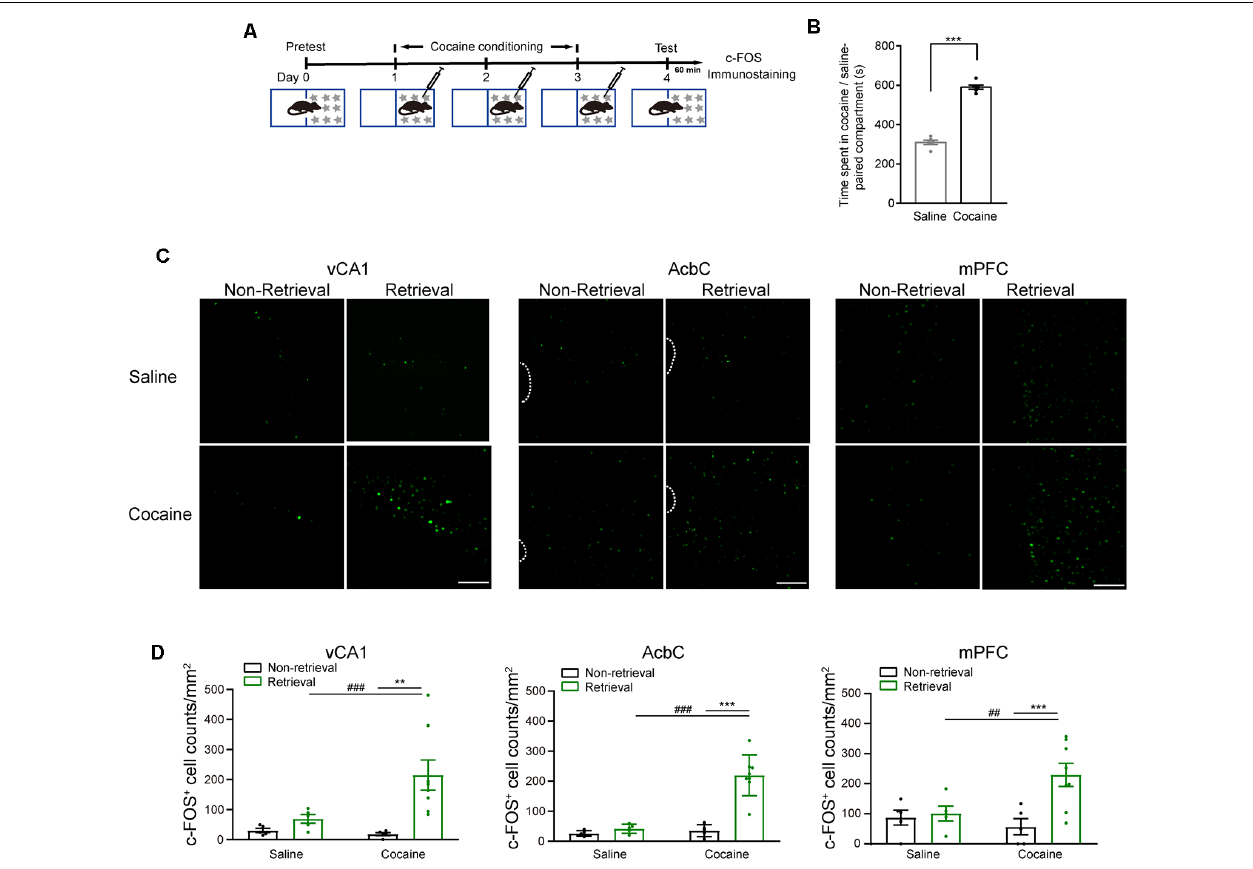
FIGURE 2 | c-Fos fluorescence increased in the vCA1, AcbC, and mPFC after retrieval of cocaine-CPP memory. (A) Experiment scheme. At 24 h after cocaine conditioning, memory retention test was performed. The mice of the retrieval group were subjected to the memory retention test and re-exposed to the CPP apparatus. The mice of the non-retrieval group remained in their home cage. The mice were perfused 60 min after memory retrieval for c-Fos immunostaining. (B) Bar graph representing the time spent in the cocaine-paired and the saline-paired compartments of the retrieval group in the memory retention test. *** P < 0.001 vs. saline-paired compartment. (C) Representative images showing c-Fos fluorescence. Scale bar: 100 µ m. (D) Quantification of c-Fos + cell counts in brain regions as indicated. ** P < 0.01, *** P < 0.001 vs. the non-retrieval group; ## P < 0.01, ### P < 0.001 vs. the saline group (saline/non-retrieval, n = 5; saline/retrieval, n = 5; cocaine/non-retrieval n = 5; cocaine/retrieval n = 8).